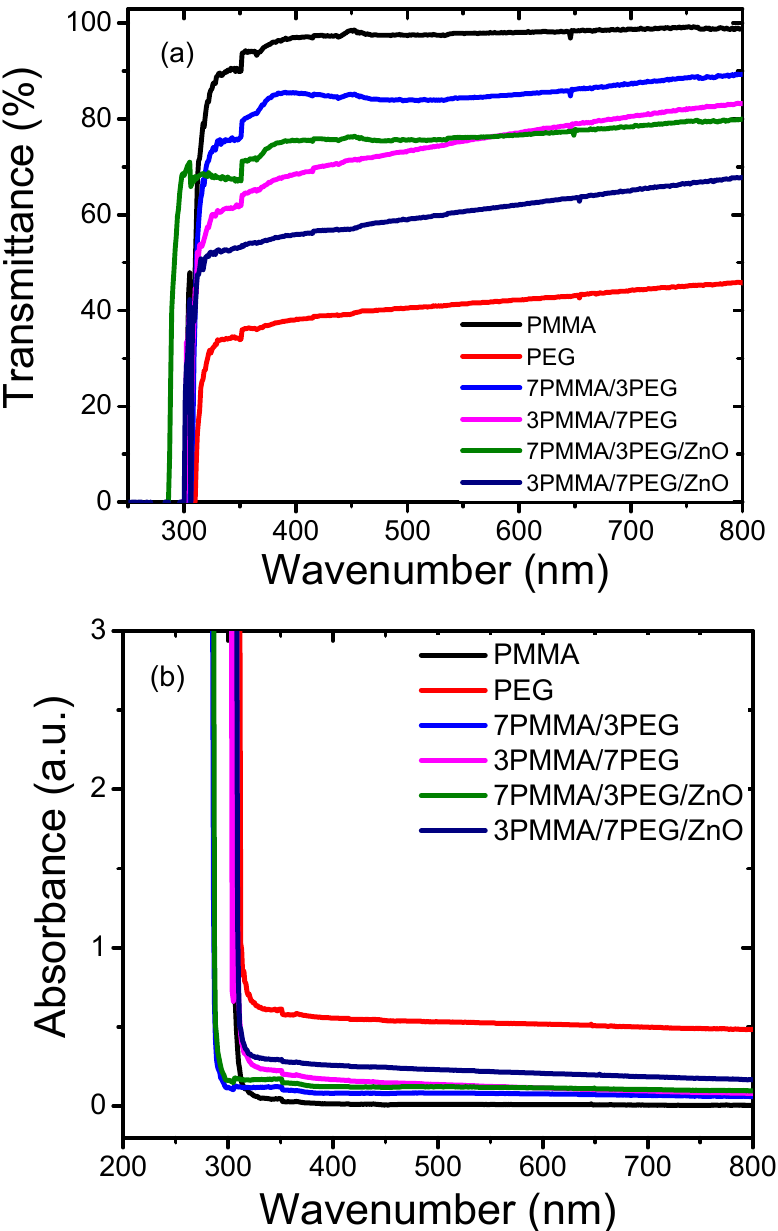
Figure 5. Optical properties of neat polymers (PMMA and PEG), polymer blends (7PMMA/3PEG and 3PMMA/7PEG) and polymer nanocomposite blends (7PMMA/3PEG/ZnO and 3PMMA/7PEG/ZnO). ( a ) UV-vis tranmittance ( b ) UV-vis absorbance. 3.5. ZnO NP Loading Reduces the Polymer Blend Band Gap Energy The optical band gap is defined as the energetic distance between the filled valence and the empty conduction bands of a solid. The ability to modulate the band gap is crucial, for instance, to develop organic light-emitting diodes, sensors, electronic devices and